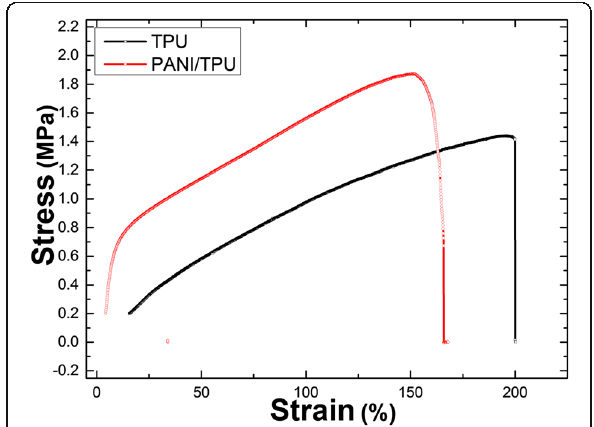
Fig. 5 Strain-stress curves of TPU and PANI/TPU nanofibrous membranes